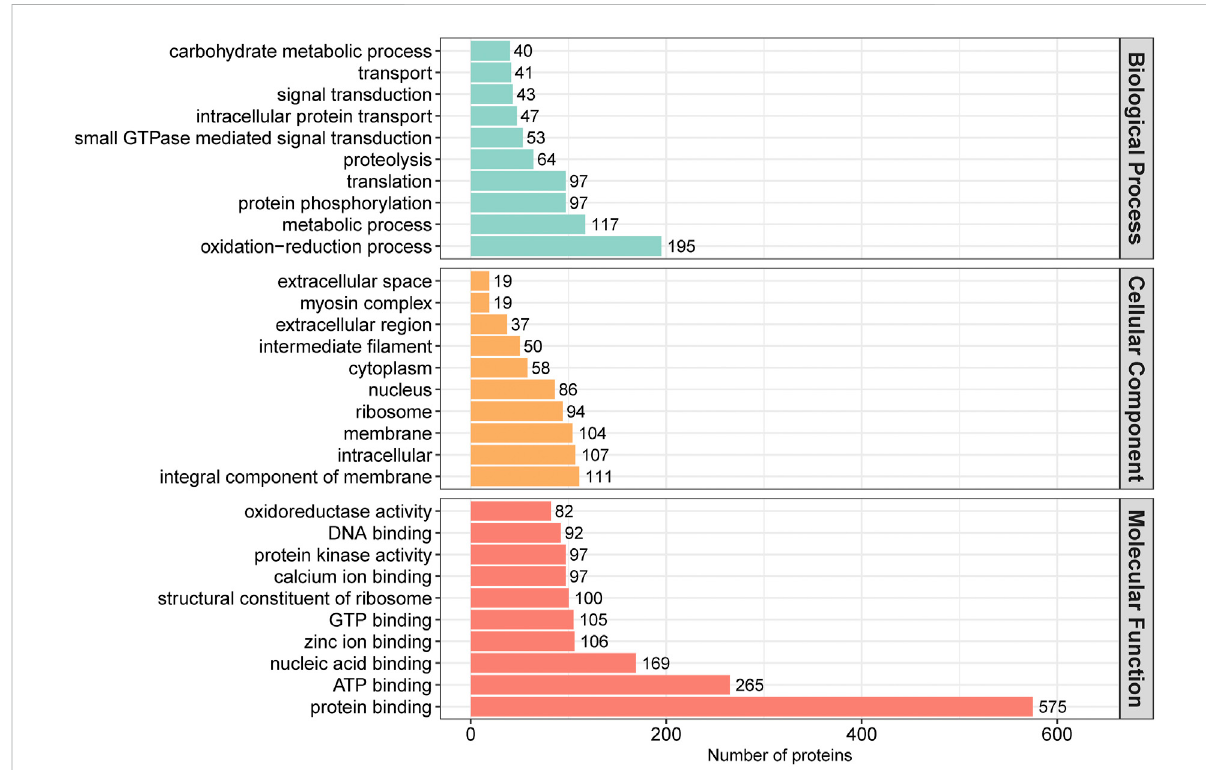
FIGURE 4 GO annotation classi fi cation of differentially abundant proteins in rumen epithelium at the age of day 0, day 15, day 30, day 45 and day